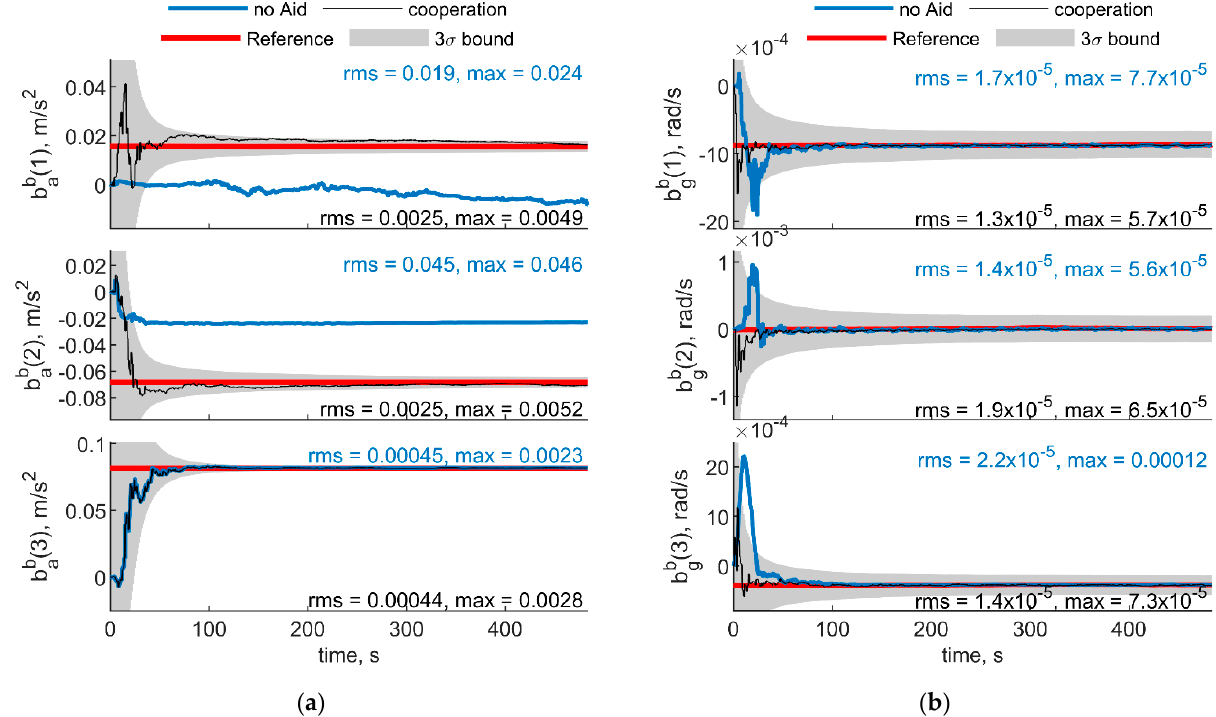
Figure 9. ( a ) Accelerometer and ( b ) gyroscope biases predicted by the filter. Chief trajectory is reported in Figure 3. Two deputies, r = 100 m, μ = 60°, Δχ = 70°. Reference value is reported in red. Results obtained with cooperation and without cooperation have been reported in black and blue, respectively. RMS and maximum error value have been evaluated starting from t = 60 s.